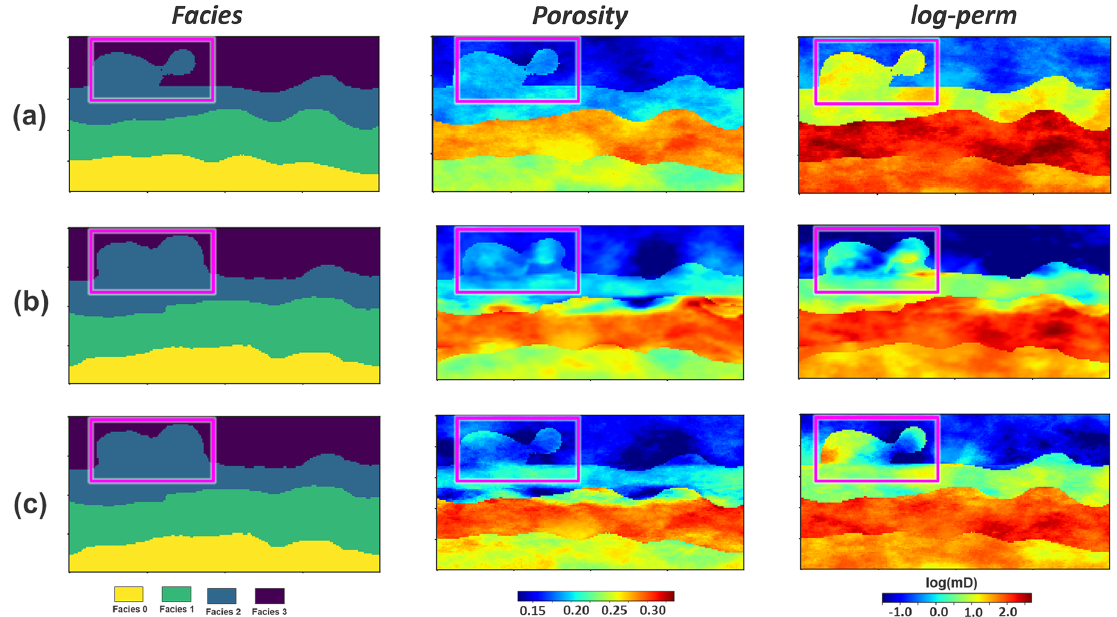
Figure 19. Prior and posterior facies, porosity and log-perm of realization no. 1 (a) prior model; (b) posterior model from the sequential decomposition; (c) posterior from joint uncertainty reduction without sequential